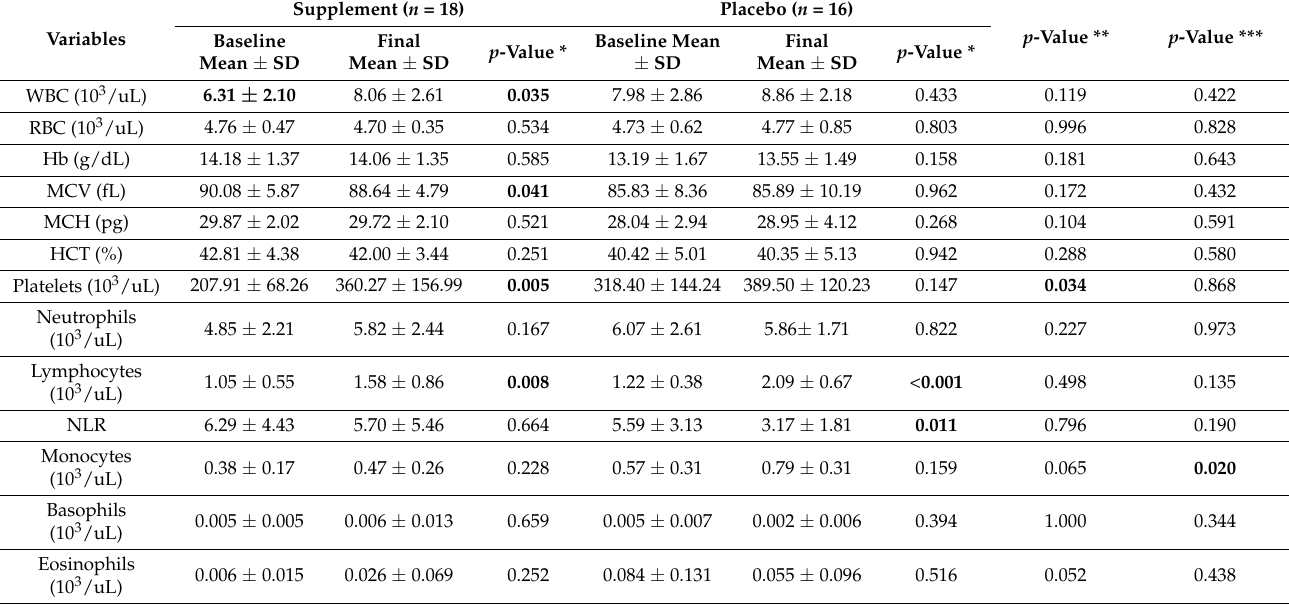
Table 3. Hematological parameters before and after intervention in both study